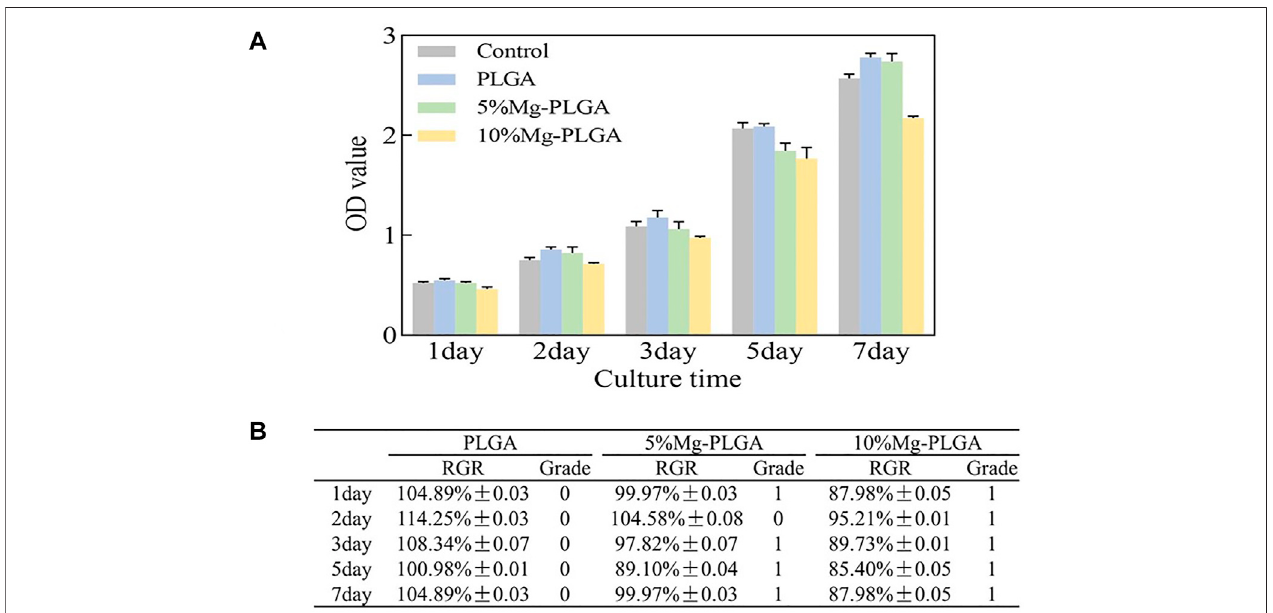
FIGURE 4 | Results of cell proliferation and cell cytotoxicity. (A) The results of the proliferation of MC3T3-E1 cells cultured with samples. The OD value of all the groups gradually increased over time. There were no statistically signi fi cant for the differences between groups ( p < 0.05). (B) The results ofthe cell toxicity grade (CTG). TheCTGofthePgroup,P5%Mggroup,andP10%Mggroupshowed0,0or1,and1,respectivelyaccordingtothestandardUnitedStatesPharmacopeia.Itindicated that all the samples showed no toxicity to